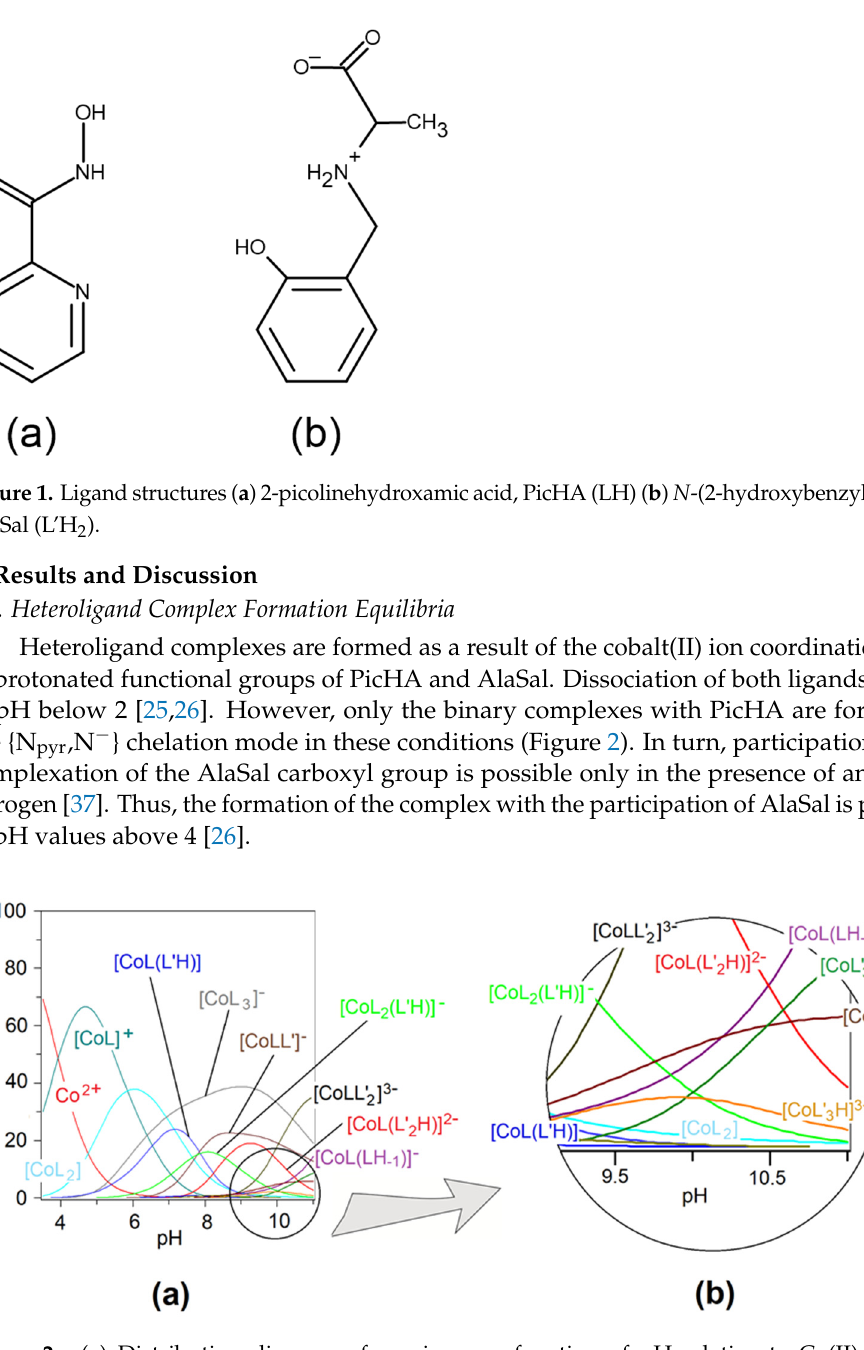
Figure 2. ( a ) Distribution diagram of species as a function of pH relative to Co(II), for the complexes formed in the Co(II)–PicHA–AlaSal system at PicHA:AlaSal:Co(II) molar ratio 2:2:1, C Co(II) = 5.0 × 10 − 3 M, ( b ) extended part of species distribution curves.